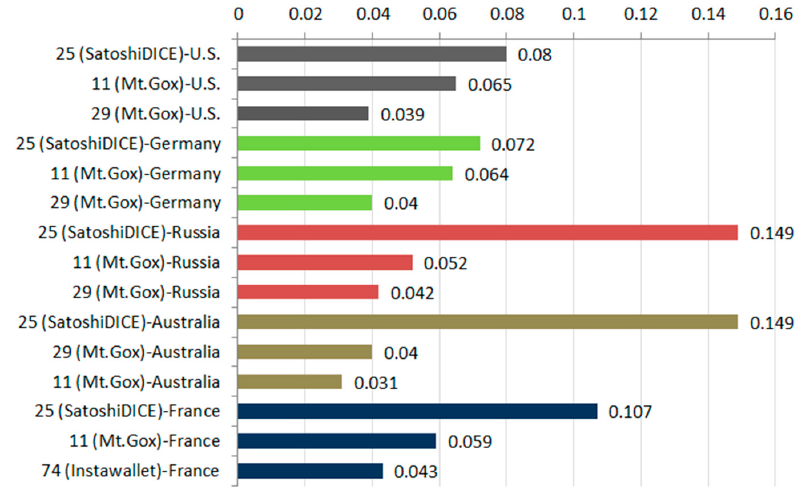
Figure 29. Degree Centrality per Country.